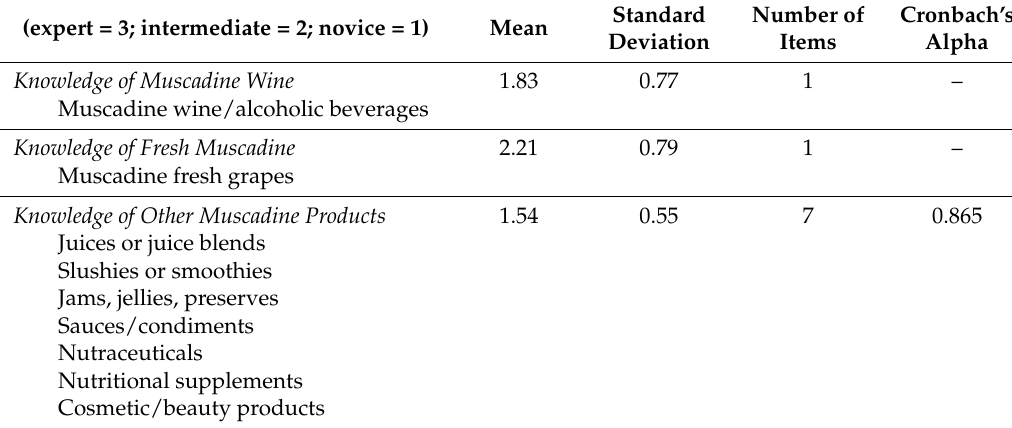
Table 1. Subjective product knowledge